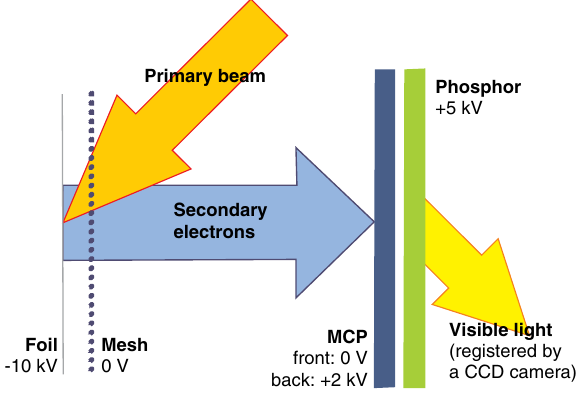
FIG. 3. Operation principle of a foil-based secondary emission